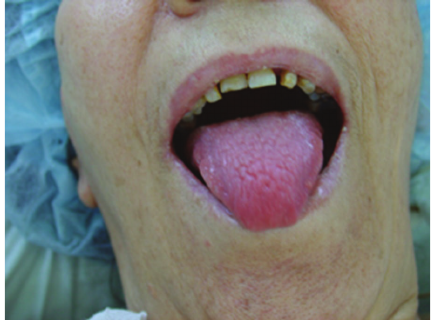
Figure 2: Glossitis.